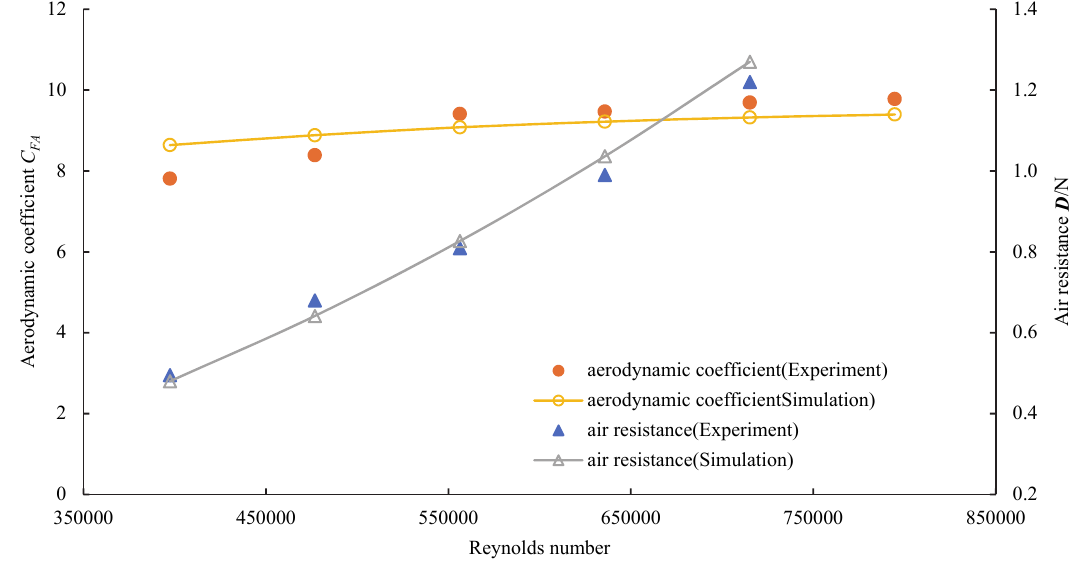
Figure 8. Wind tunnel test results.